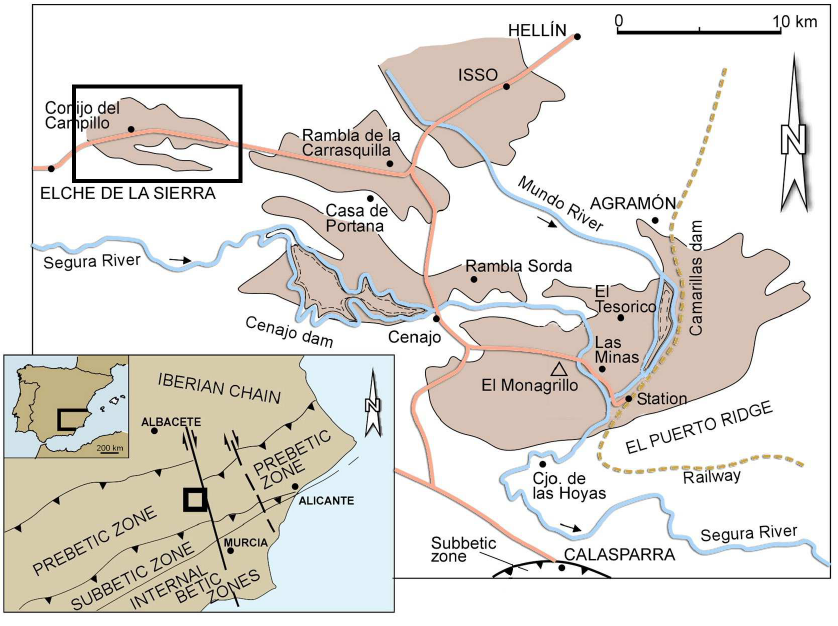
Figure 1. Neogene basins on the external side of the Betic Ranges, and location of the Elche de la Sierra basin (black rectangle in the upper-left corner) (modified from